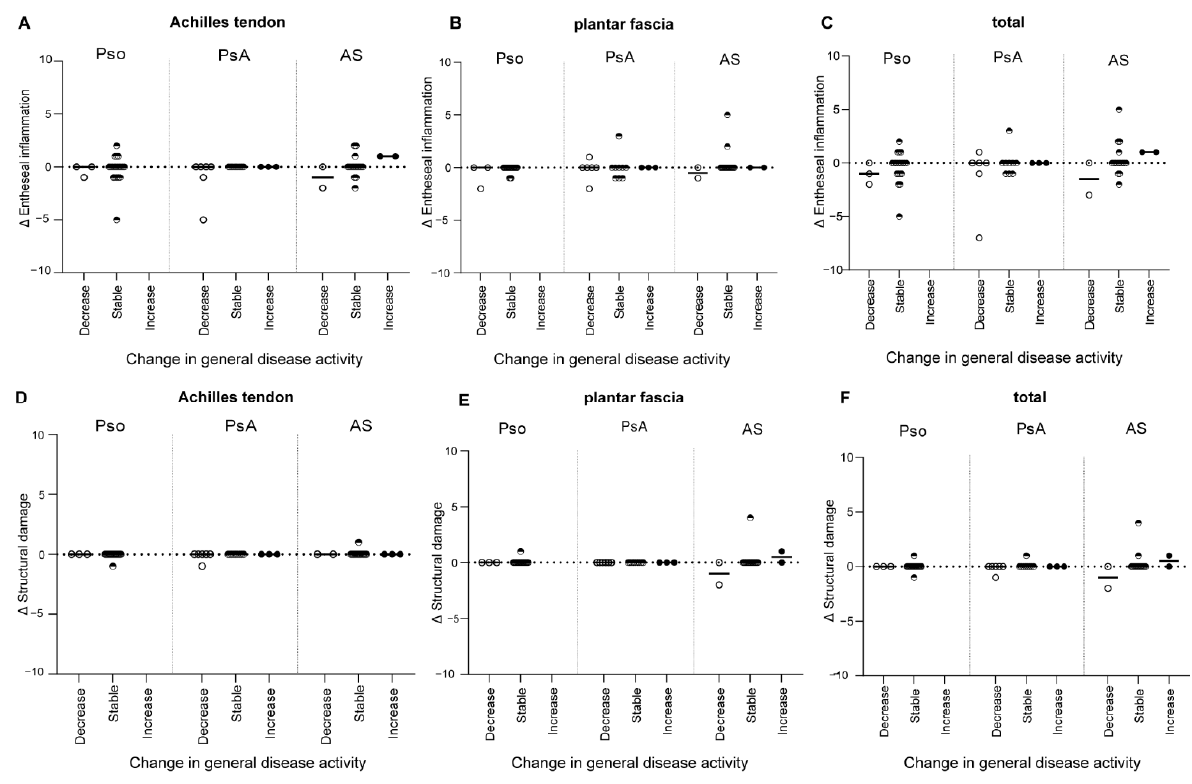
Figure 6. Changes in the HEMRIS in Pso, PsA and AS patients with different levels of change in general disease activity. Change in general disease activity was not associated with change in HEMRIS at the area of the Achilles tendon ( A , D ), plantar fascia ( B , E ), and Achilles tendon and plantar fascia combined (total HEMRIS; ( C , F )), in patients with Pso, PsA and AS. Data are presented as the median change and individual values of change in HEMRIS (Delta HEMRIS). Figure Legend: Abbreviations: Δ = delta, HEMRIS = Heel Enthesitis Scoring System, Pso = psoriasis, PsA = psoriatic arthritis, AS = ankylosing spondylitis.